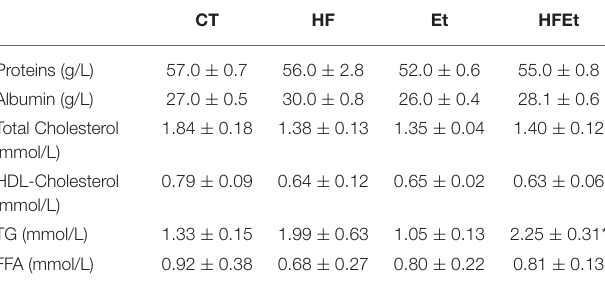
TABLE 2 | Biochemical assays on plasma in rats fed during 6 weeks with Control (CT), High Fructose (HF), Ethanol (Et), or a mix (HFEt)